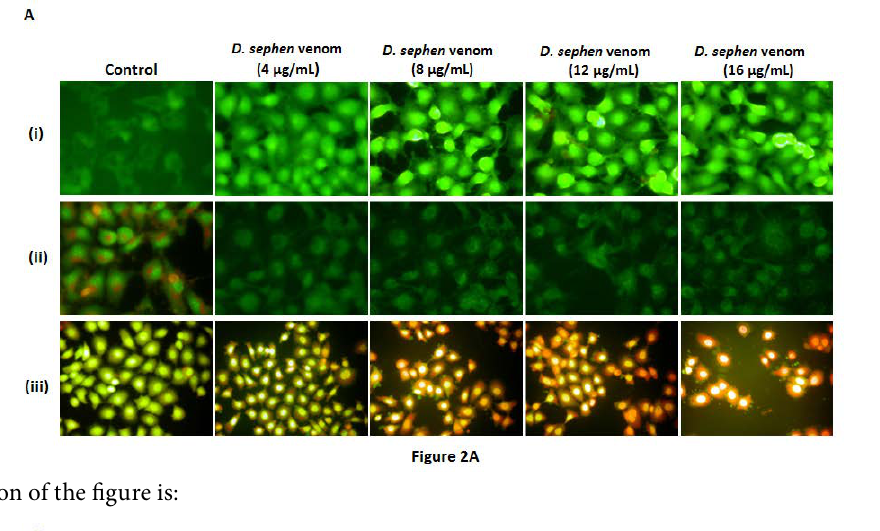
Figure 2A inadvertently contained a mistake. The second panel of line (ii) is the same of the third one, of